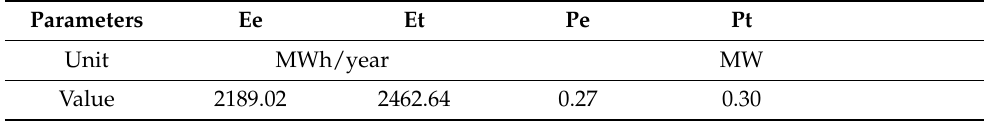
Table 7. Energetic revenue of produced